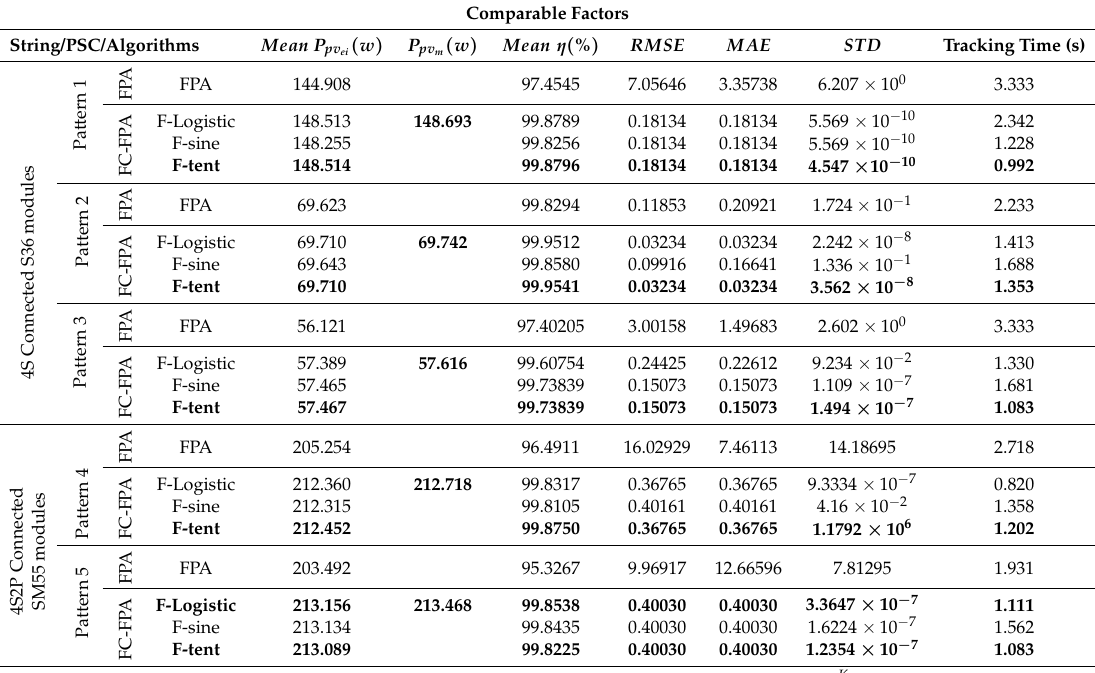
Table 6. Comparison between MPPT variants over the five